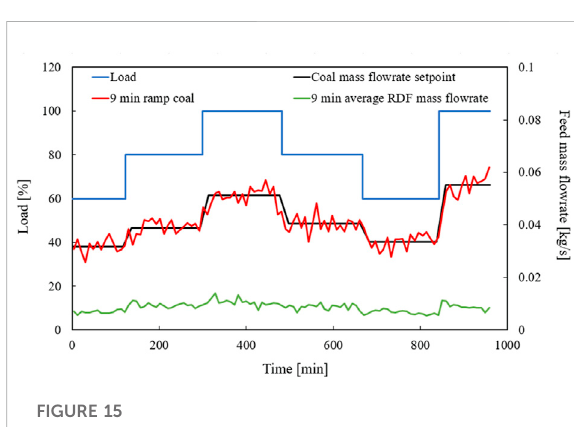
FIGURE 15 Dynamic curve of the fuel mass fl ow